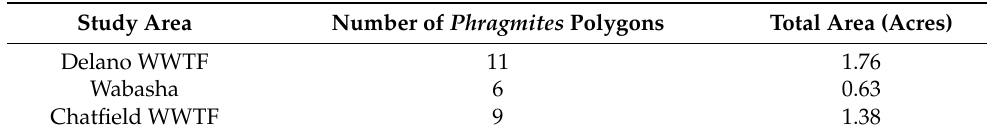
Table 6. Number of Phragmites polygons digitized and the total area in acres of Phragmites per study